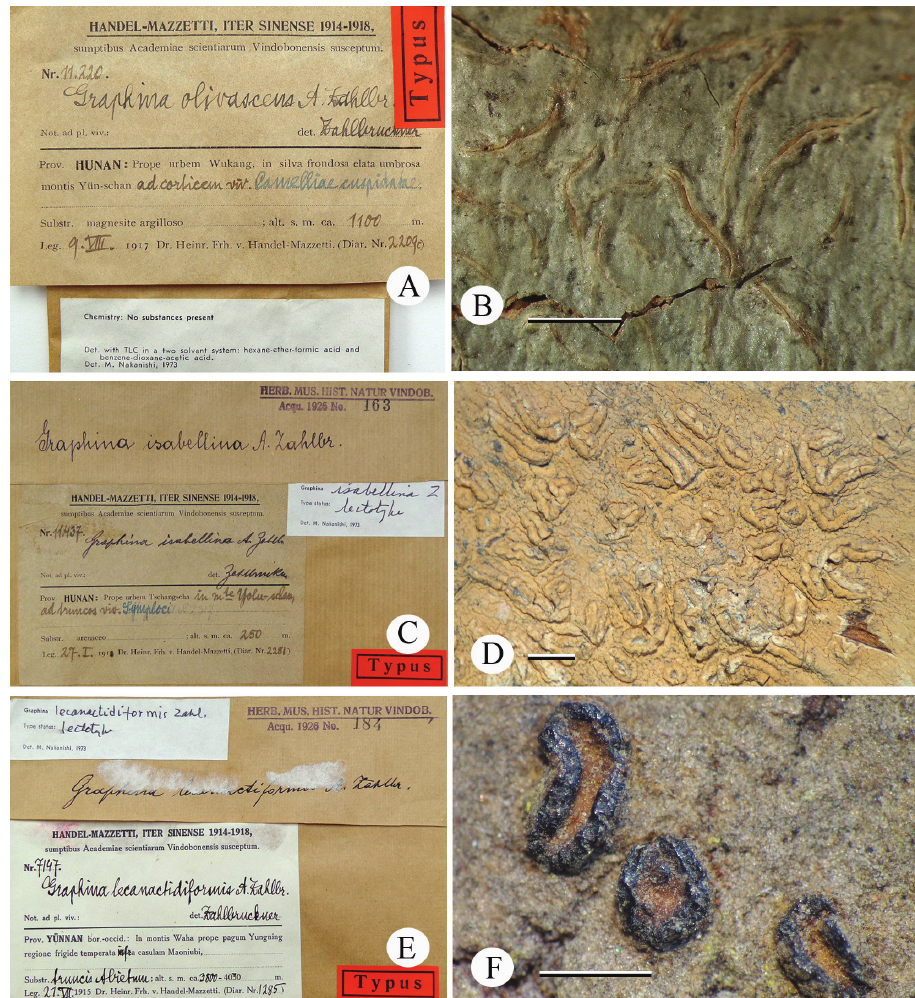
Figuer 1. A, B Type Graphina olivascens ( Handel-Mazzetti 11220 ) C, D Type Graphina isabellina ( Han- del-Mazzetti 11437 ) E, F Type Graphina lecanactiformis ( Handel-Mazzetti 7147 ).